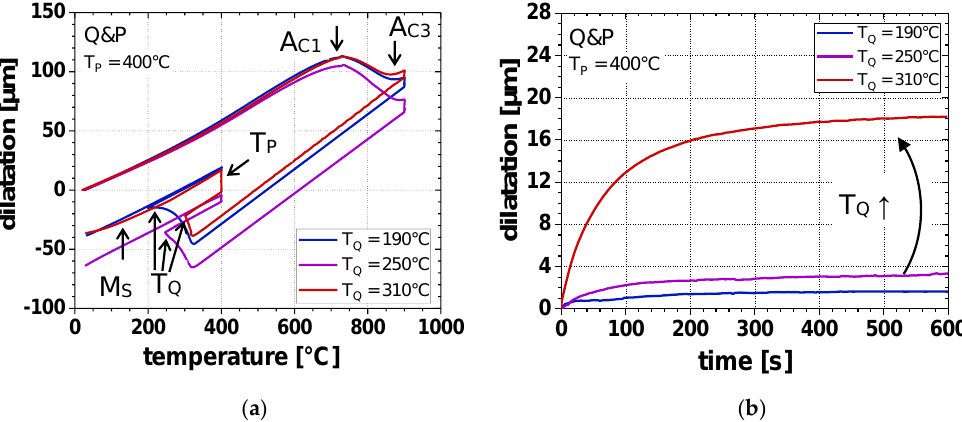
Figure 5. ( a ) Dilatometric curves at different T Q ( T P = 400 °C) and ( b ) dilatation due to α B formation as a function of isothermal holding time at different T Q ( T P = 400 °C).